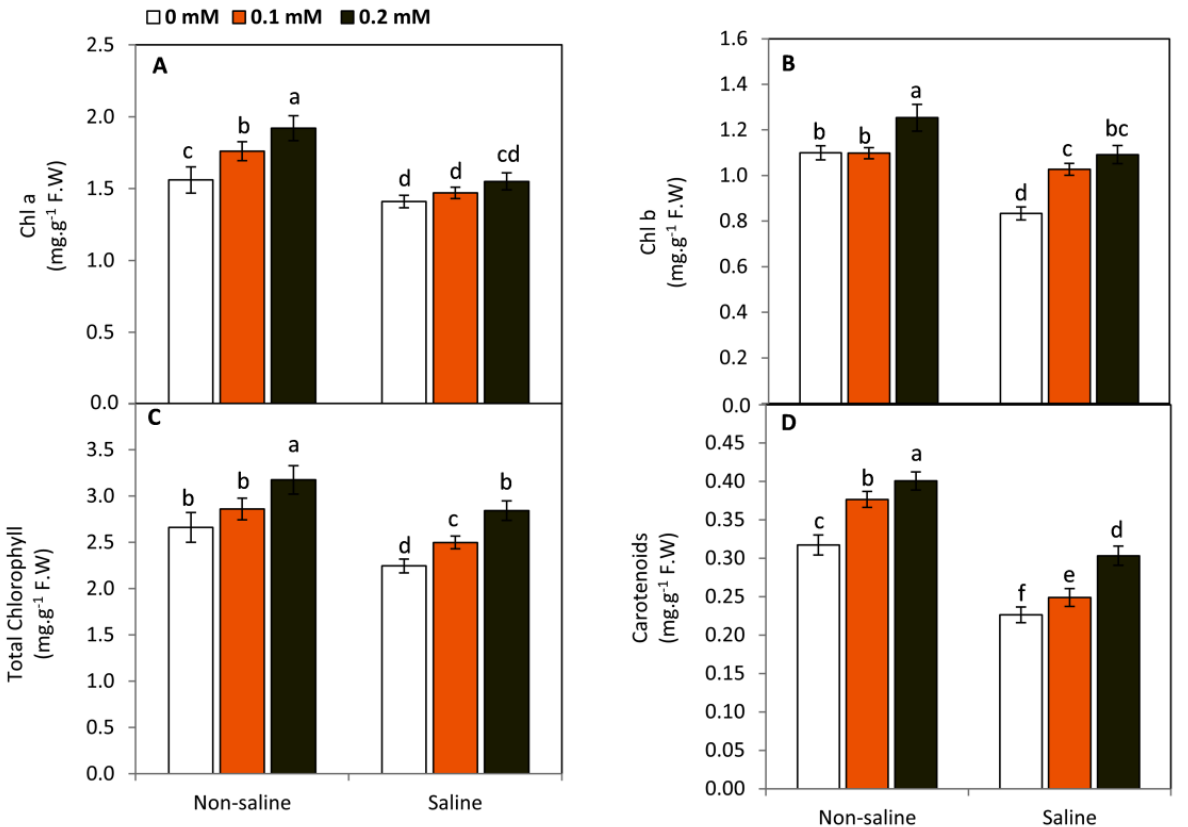
Figure 2. Effect of exogenous folic acid (FA; 0, 0.1, and 0.2 mM) on photosynthetic pigments in- cluding Chl a ( A ), Chl b ( B ), total chlorophyll ( C ), and carotenoids ( D ) of snap bean plants grown under non-stressed and saline-stressed (50 mM, NaCl) conditions. Values are the averages of three replicates ± SD. Different letters indicate significant differences according to Duncan’s multiple range tests ( p < 0.05).